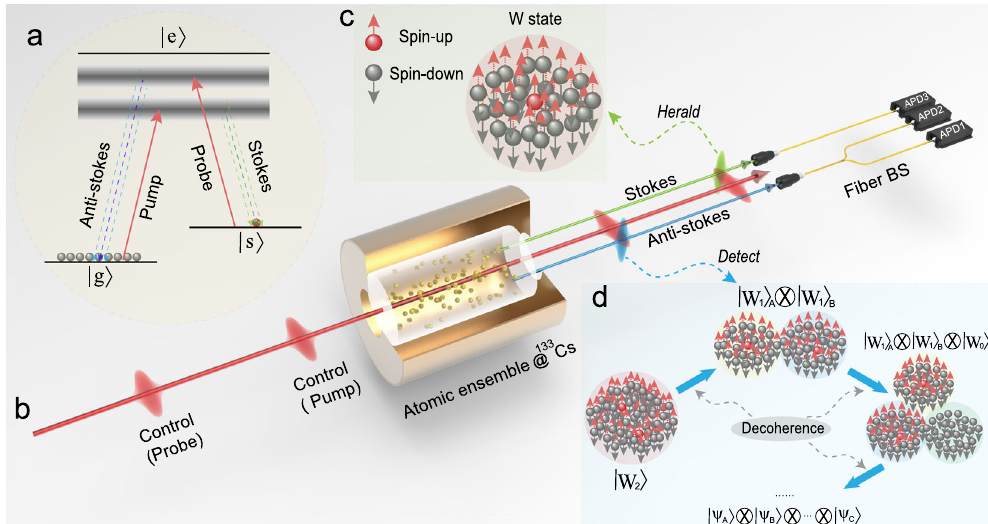
Fig. 1 The schematic diagram of creation and veri fi cation of multipartite entanglement. a The energy levels of creating and verifying W state. Solid lines represent three-level Λ -type con fi guration of atoms, two ground states label g j i (6 S 1/2 , F = 3) with electronic spin down and s j i (6 S 1/2 , F = 4) with electronic spin up, which are hyper fi ne ground states of cesium atoms (splitting is Δ g = 9.2 GHz); excited state labels e j i ( 6 P 3 = 2 ; F 0 ¼ 2 ; 3 ; 4 ; 5 ). The shaded area between energy levels represents broad virtual energy levels induced by the short pump and probe laser pulse (2 ns). b The experimental scheme of creating and certifying the multipartite entanglement. The Hanbury Brown – Twiss interferometer is used for analyzing the statistics of the correlated Stokes and anti-Stokes photons, which can further reveal the information of entanglement depth. c The dashed red arrows means that every atom has an equal probability to be spin up or down, which is the main feature of the W state. d The decoherence effects may change the structure of the multipartite entanglement. We take the two excitations event as examples to show the evolution of entanglement depth. The distributed cesium atoms with different colors illustrate the entanglement distribution with several subgroups. The set of same-colored atoms is genuine multipartite entanglement, while two sets with different colors do not have the relationship of